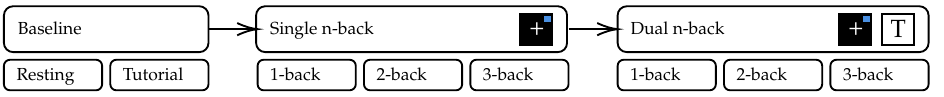
Figure 6. Visualization of the n -back test protocol. Baseline measurement consists of a resting phase of 5 min, followed by a 2 min tutorial, that shows stimuli and explains input controls to the subject. Two distinct phases of single and dual task n -back tests for n